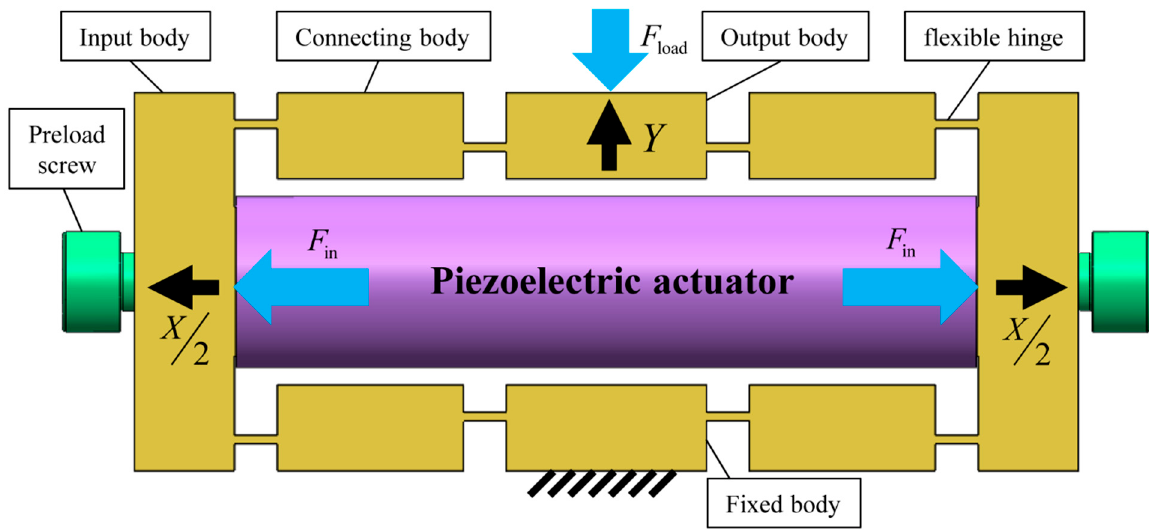
Figure 1. Schematic diagram of the bridge-type displacement amplification mechanism.